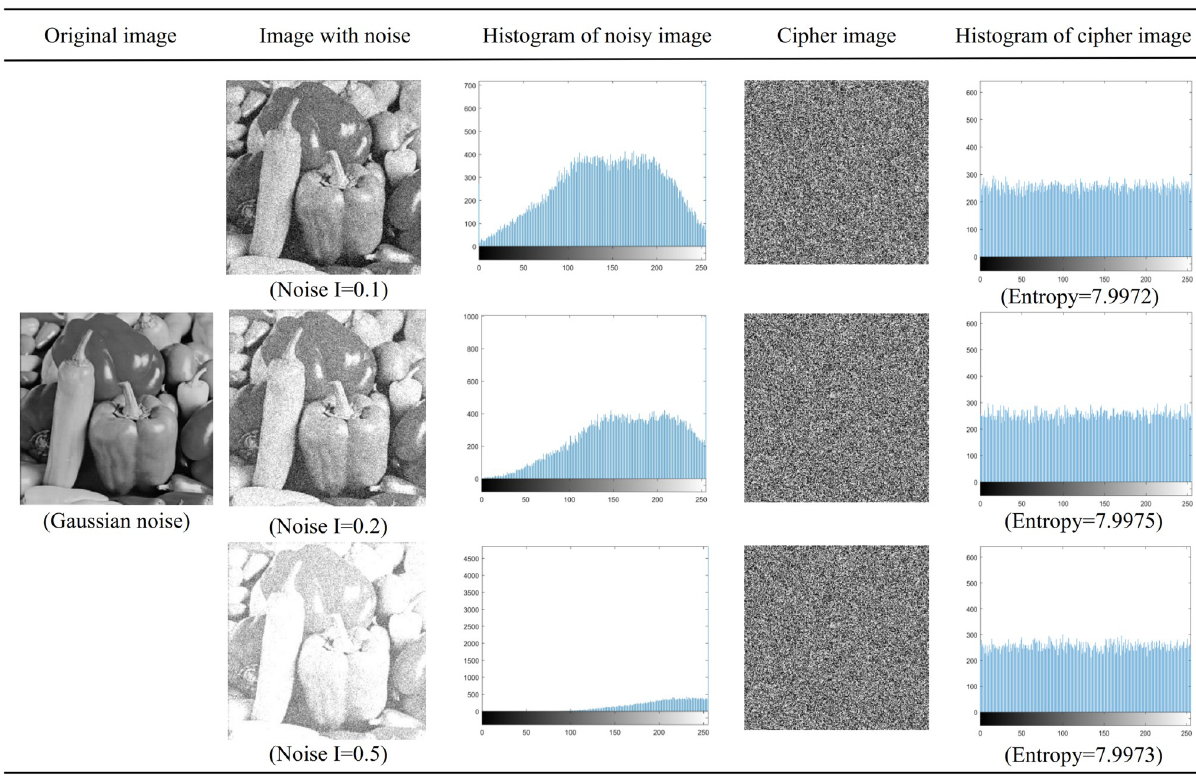
Fig 15. Histogram analysis and entropy analysis of Gaussian noise image and encrypted image.